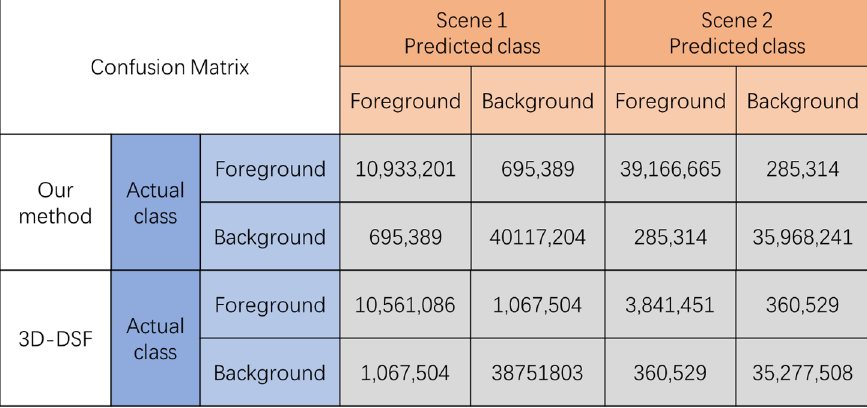
Figure 17. CM on two scenes using our method and 3D ‐ DSF at long distances.